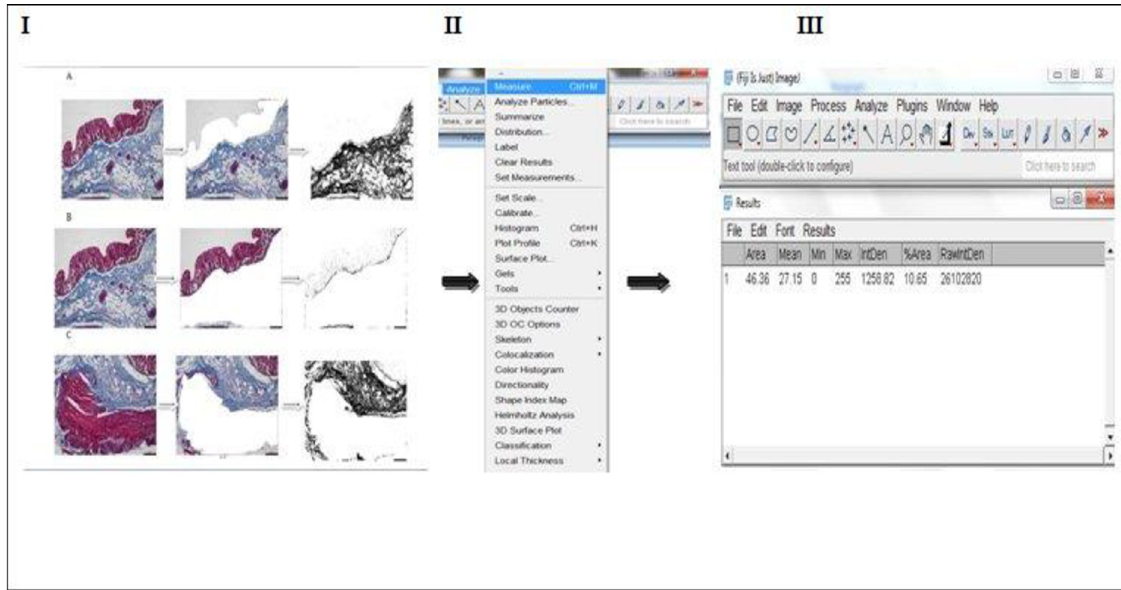
Fig 4. Quantification of total collagen fibres distributed in human colon using ImageJ software. ( I ) Grayscale images of Masson’s trichrome stained colonic sections were circumscribed with freehand tool in the ( A ), mucosa (an area consisting of the entire epithelium and muscularis mucosae); ( B ) Submucosa (region below the muscularis mucosae to the area just below the edge of circular muscle layer) and ( C ) Muscularis externa (an area of the circular and longitudinal muscle layer without the serosa). ( II ) When “Analyse” from the menu and “Measure” is selected, the result is presented in ( III ). Scale bars represent 60 μ m.